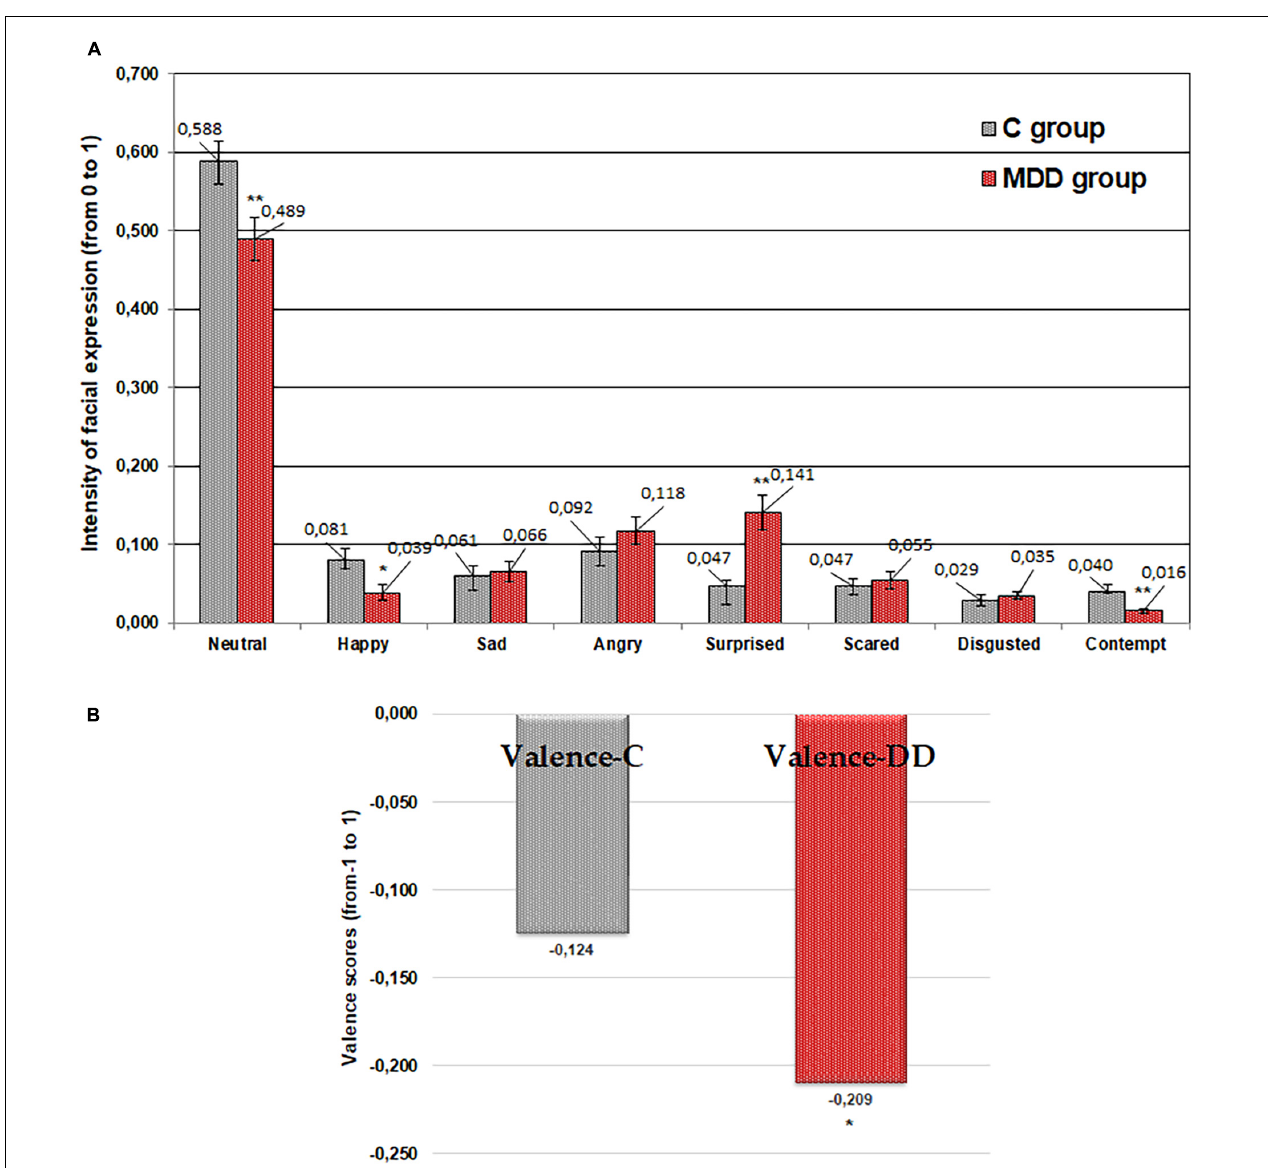
FIGURE 4 | Emotions (“neutral,” “happy,” “sad,” “angry,” “surprised, ” “scared,” “disgusted,” and “contempt”) induced by imagined “bitter” tasting food (A) and valence (B) for patients with major depressive disorder (MDD group) and without MDD (C group). Significant difference between groups: *p ≤ 0.05; **p ≤ 0.01.